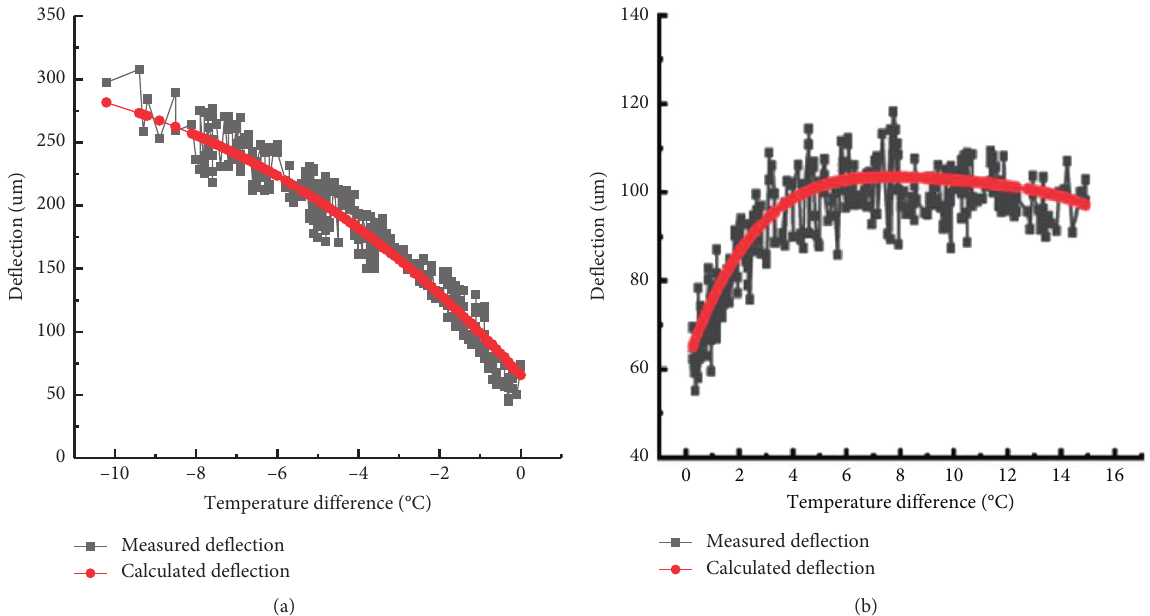
Figure 8: Comparison between experimental and the calculated deflection values of positive and negative temperature differences. (a) Negative temperature range. (b) Positive temperature